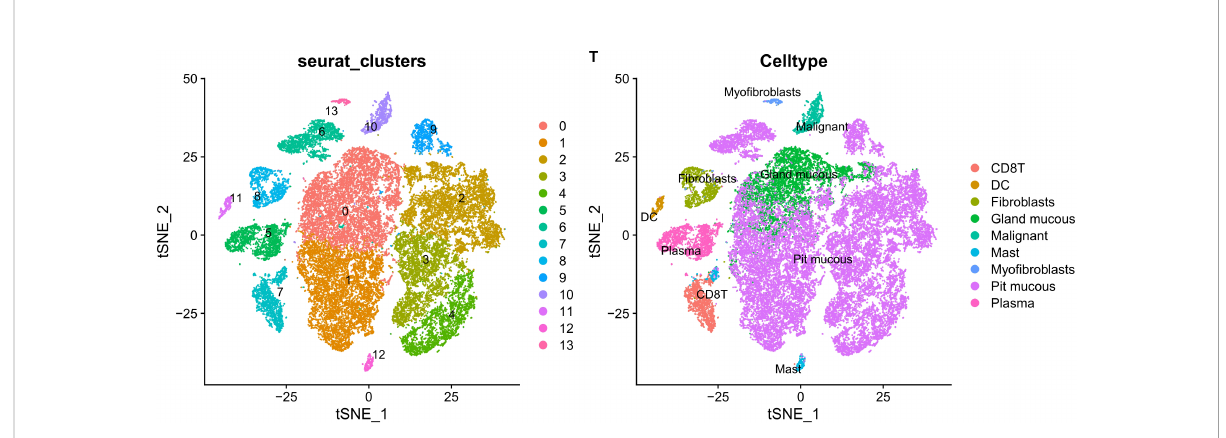
FIGURE 11 The tSNE algorithm reduced the dimension of 15 PCA and classi fi ed 9 kinds of